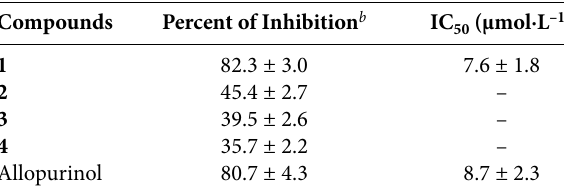
Figure 8. Molecular packing diagram of 4 , viewed along the b axis. Hydrogen bonds are shown as dashed lines. Table 3. Inhibition of XO by the compounds